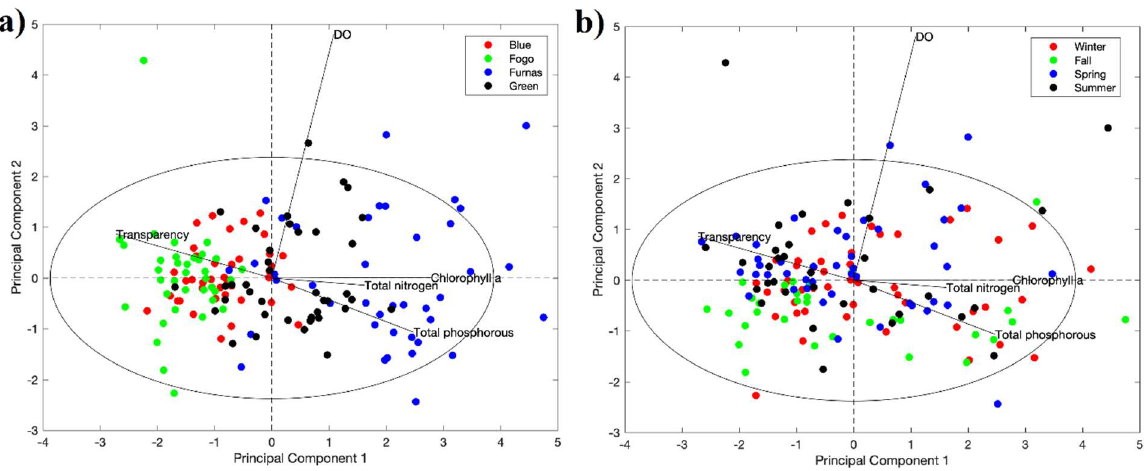
Figure 4. Biplots for the multivariate analysis of trophic data considering their descriptors, colored according to the lake ( a ) and season ( b ). according to the lake ( a ) and season ( b